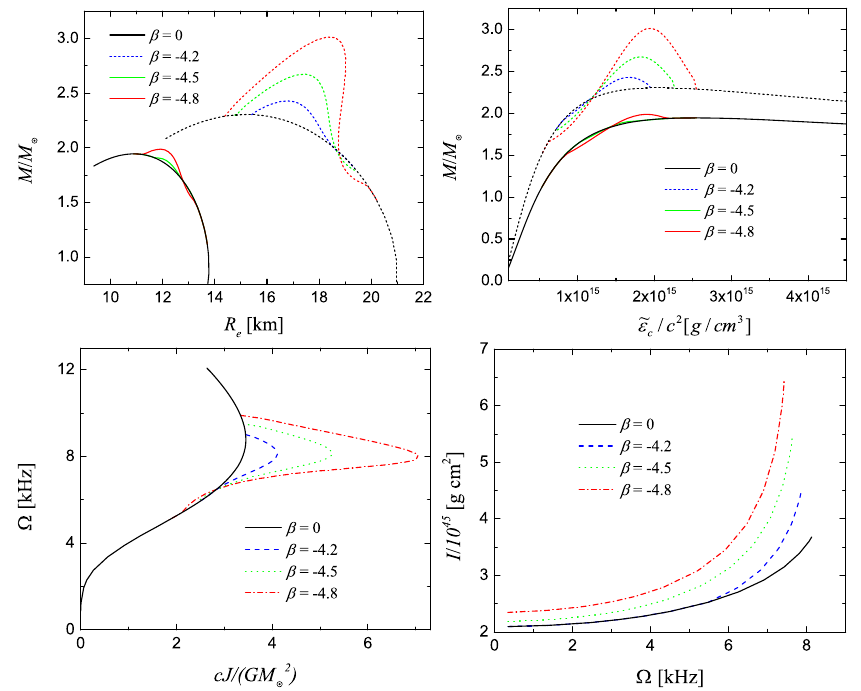
Fig. 6 From left to right, top to bottom the plots correspond to mass versus radius, mass vs central energy density, angular frequency versus dimensionless angular momentum, and moment of inertia versus angular frequency. For the plots in the top row, solid lines correspond to nonrotating stars, while dotted lines correspondtothemass-sheddingsequence.Theangularfrequencyversusdimensionlessangularmomentum has only the mass-shedding sequence, while the moment of inertia plot corresponds to models for which the central energy density is fixed at ∼ (cid:19) c / c 2 = 1 . 5 × 10 15 g / cm 3 . (Image reproduced with permission from Doneva et al. 2013b, copyright by